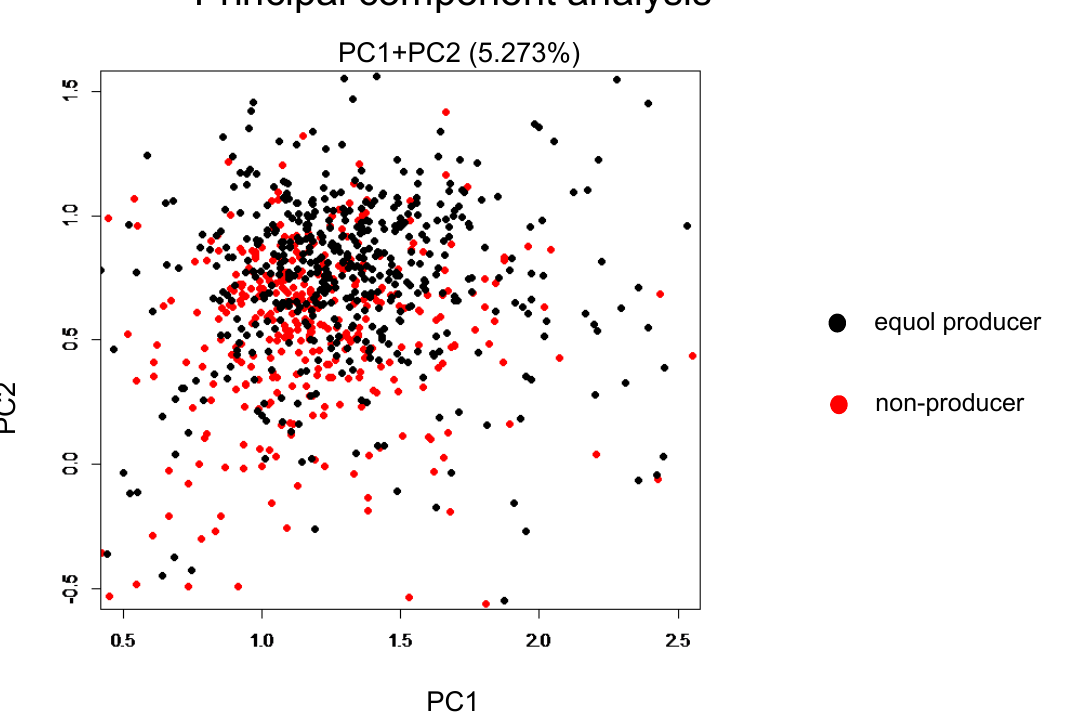
Figure 2. ( a ) The Shannon index and ( b ) Chao1 index of the gut microbiota in the equol producers and non ‐ producers.